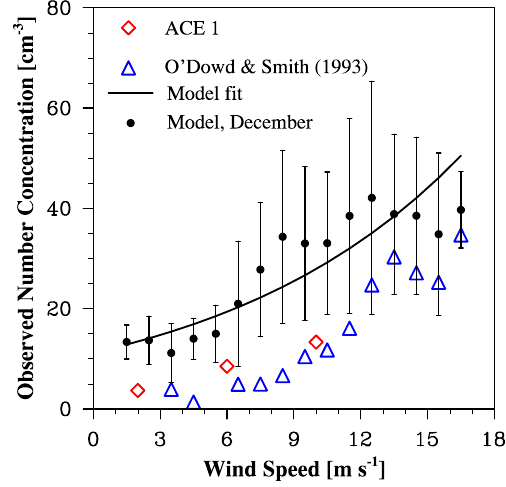
Fig. 12. Wind dependence of number concentration of the model in the South Pacific compared to the function of O’Dowd and Smith (1993) and the ACE-1 data. The error bars represent one-standard deviation of the model results. The model and O’Dowd and Smith data are for dry radius 0.05–0.15µm and 0.19–0.42µm. The ACE-1 data are for radius 0.075–0.5µm. The model used the CMS source function and a solubility factor of 0.5. Figure 12 indicates the model values have a zero wind offset (of about 10cm − 3 ) , which is larger than the observed zero wind speed